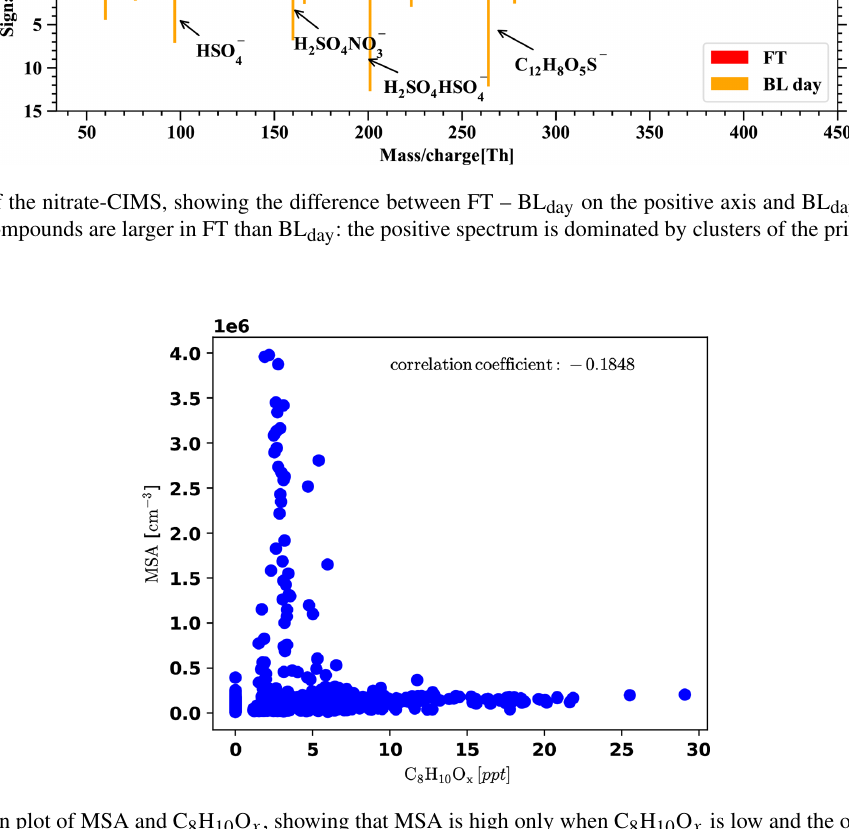
Figure D4. Correlation plot of MSA and C 8 H 10 O x , showing that MSA is high only when C 8 H 10 O x is low and the other way round.